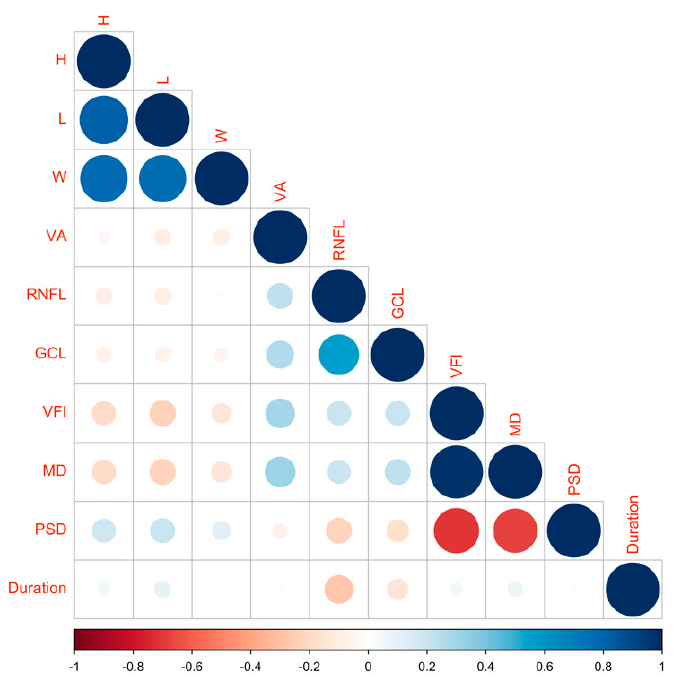
Figure 2. The correlation between visual severity, duration of symptoms, and size of the tumor. H: tumor height; L: tumor length; W: tumor width; VA: visual acuity; GCL: ganglion cell layer; VFI: visual field index; MD: mean deviation; PSD: pattern standard deviation. Table 2. Ophthalmic examinations in patients with different diagnoses and different